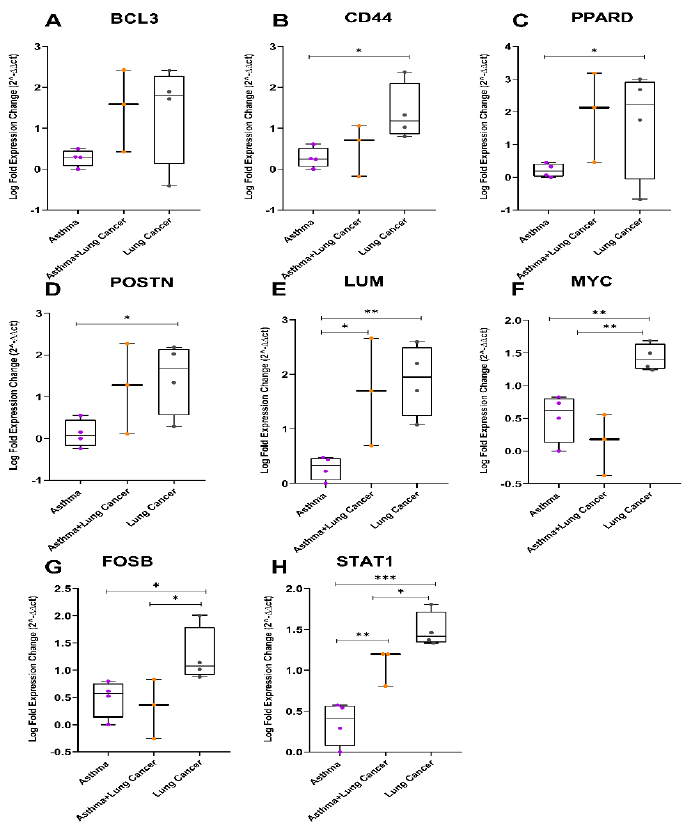
Figure 8. Boxplots for the differentially expressed genes among severe asthmatics, lung cancer and asthmatics with lung cancer development validated by RT-qPCR analysis in archival tissue biopsies. ( A ) BCL3 , ( B ) CD44 , ( C ) PPARD , ( D ) POSTN , ( E ) LUM , ( F ) MYC , ( G ) FOSB , and ( H ) STAT1 (Mann − Whitney test, significance * p < 0.05, ** p < 0.01, *** p < 0.001).